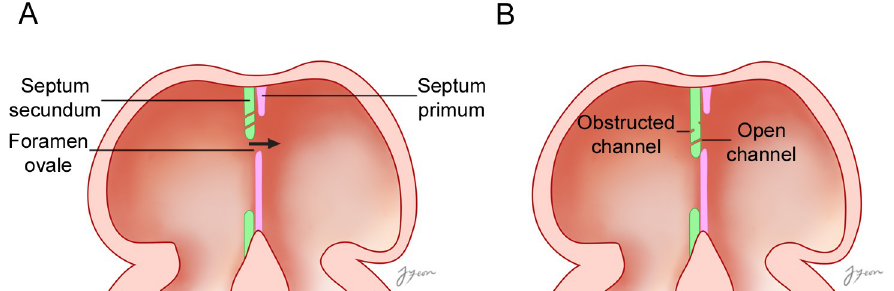
Fig 5. An embryological model of the formation of an IAC during the development of the atrial septa. (A) As the septum secundum develops, the blood flows from the right atrium to the left atrium, which results in the formation of several tiny channels through the septum secundum. (B) As development proceeds, most of these tiny holes became blocked completely due to the proliferation of muscle cells in the interatrial septum, with or without leaving holes on the surfaces of the septum. The blocked channel, having holes on the septal surface, evolves into a blocked IAC. Some channels were not blocked, kept open by the blood flow, and became open IACs. The arrow indicates the direction of blood flow.